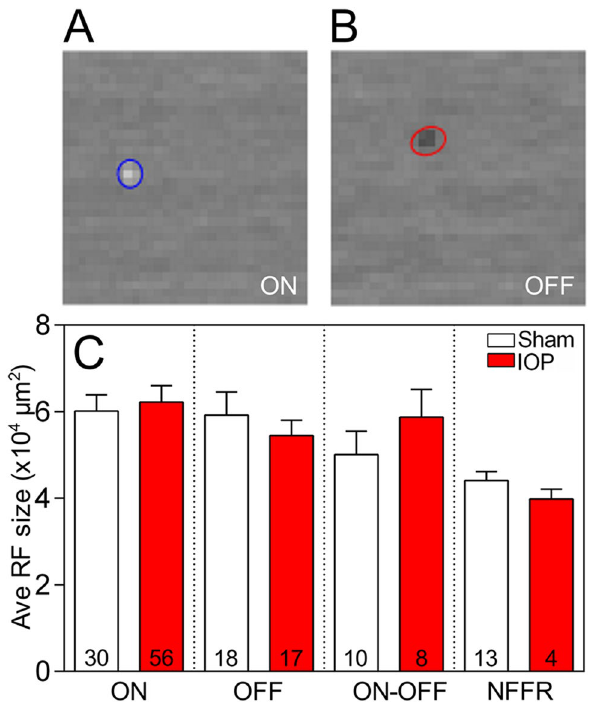
Figure 3. Receptive field size was not altered in any RGC type following acute IOP elevation. ( A, B ) The receptive field (RF) size calculated from the spike-triggered average of an ON ( A ) and OFF ( B ) RGC. Some cells that did not respond to the full field stimuli (NFFR cells) showed an STA response while others that were full field responsive had no STA, thus cells were still classified on their full field response and those with STAs compared. None of the RGC subtypes showed a change in receptive field size in sham (white bars) relative to IOP elevated (red bars) eyes ( C ). Numbers in histograms indicate number of cells recorded from n = 6–10